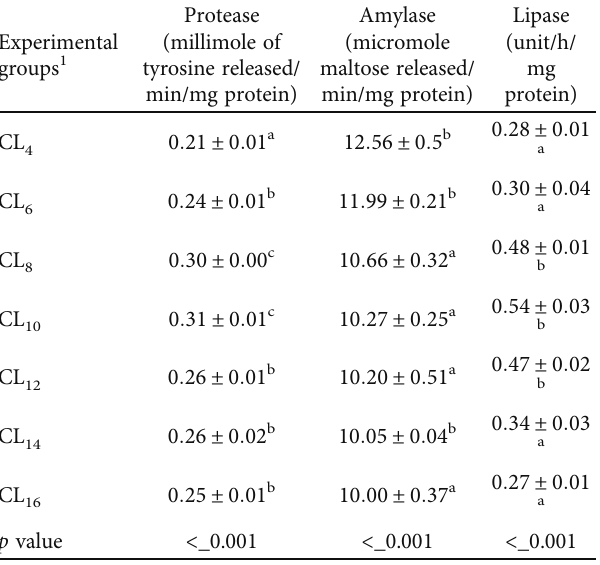
Table 4: Digestive enzymes activities in the intestine of GIFT juveniles cultured in IGSW of 15 ppt and fed with experimental diets for 60